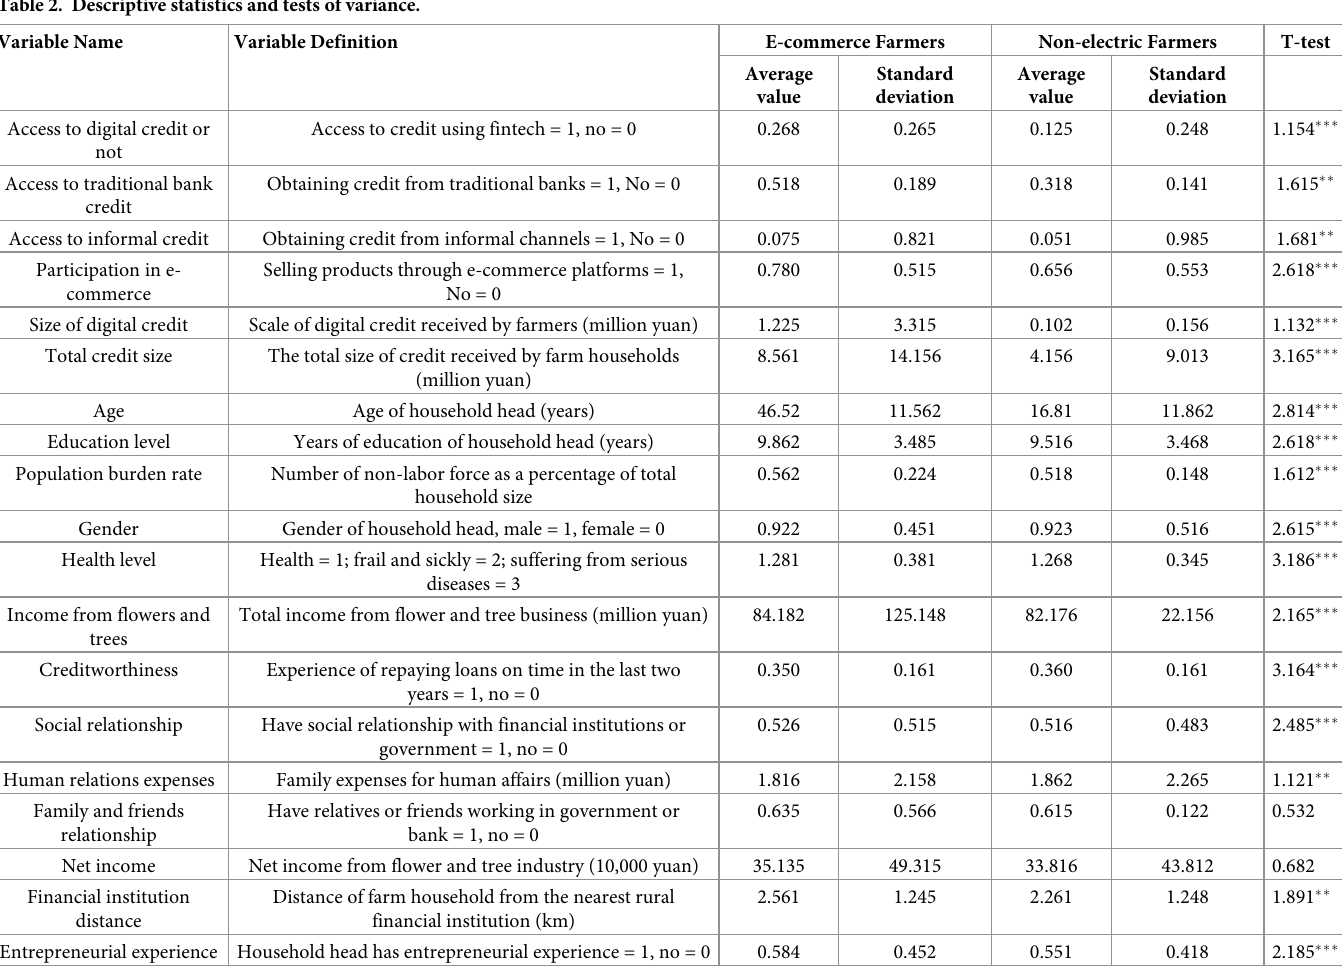
Table 2. Descriptive statistics and tests of